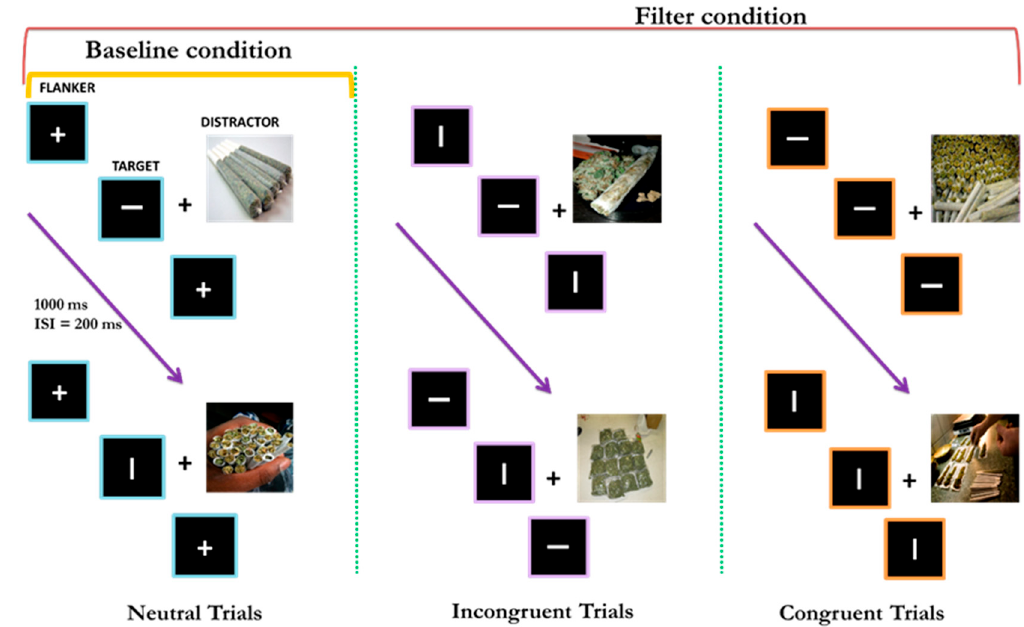
Figure 1. Modified flanker task, made up of a block of 80 trials, each consisting of a fixation square followed by the first flanker, target, and second flanker (stimulus displays), presented sequentially for 150 ms separated by a random interstimulus interval (153–390 ms). The target was represented by a vertical or horizontal line, or a cross superimposed on a cannabis-related picture or a neutral, positive, or negative image from the International Affective Picture System (IAPS) [42].